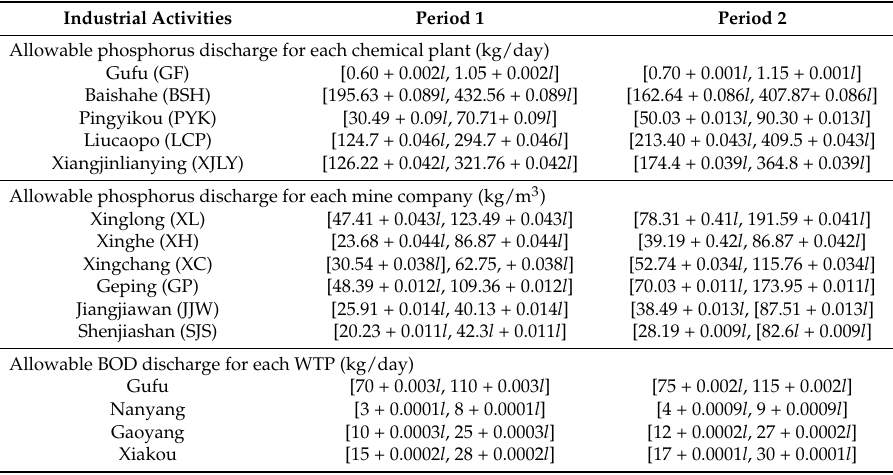
Table 2. Allowable pollutant discharges for industrial